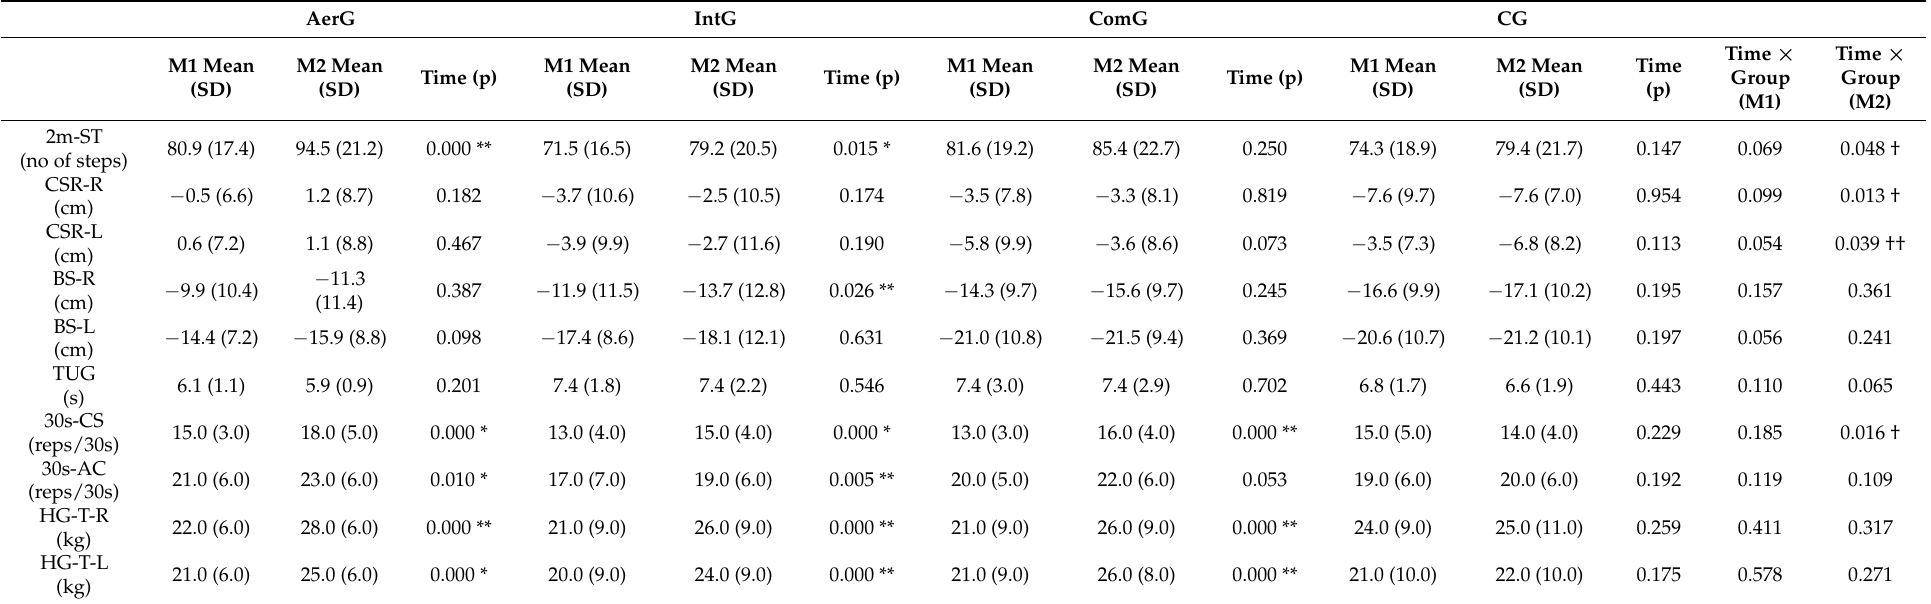
Table 3. Functional fitness results variation analysed by type of aquatic exercise program before and after